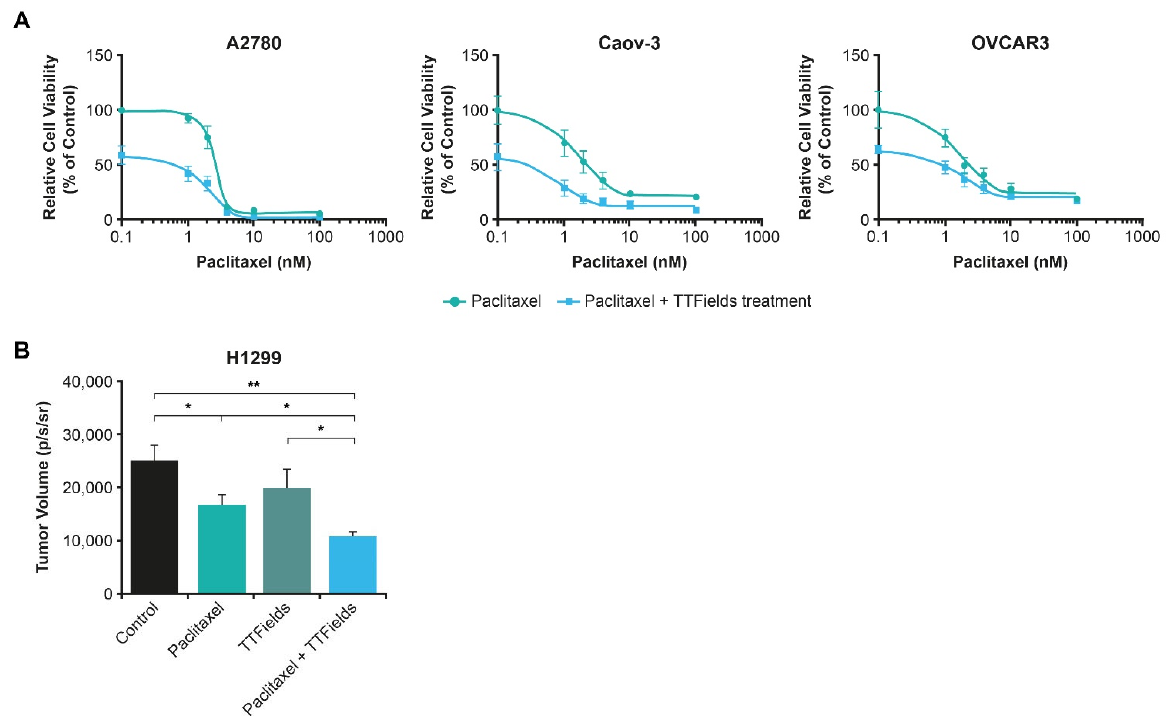
Figure 4. The efficacy of the TTFields treatment and paclitaxel on ( A ) human ovarian cell line (A2780, OVCAR3, Caov ‐ 3) count and ( B ) tumor volume for in vivo murine model figure. * p < 0.05 and ** p < 0.001. A2780: OVCAR3, Caov ‐ 3, human ovarian cancer cell lines; p/s/sr: photons per second per steradian; TTFields: Tumor Treating Fields. Reproduced from Voloshin T et al.